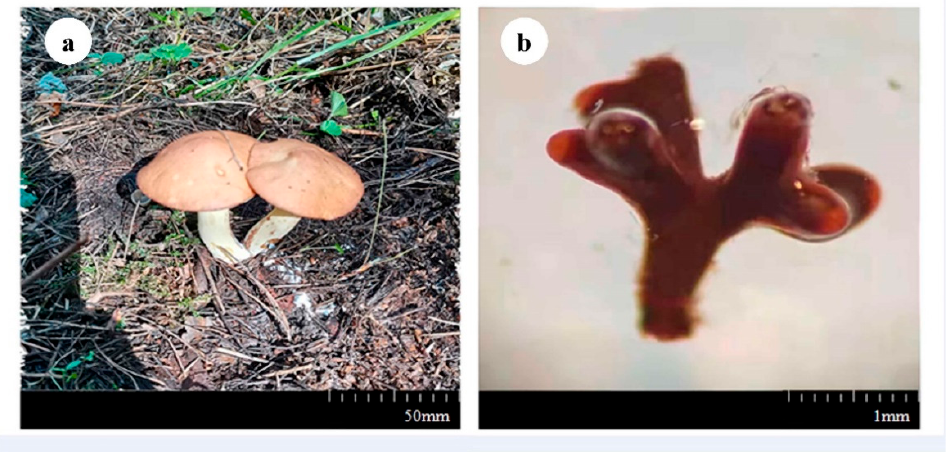
Figure 2. ( a ) Morphosis of the fruiting body of Suillus luteus . ( b ) Morphosis of the mycorrhizae of Suillus luteus (10×).